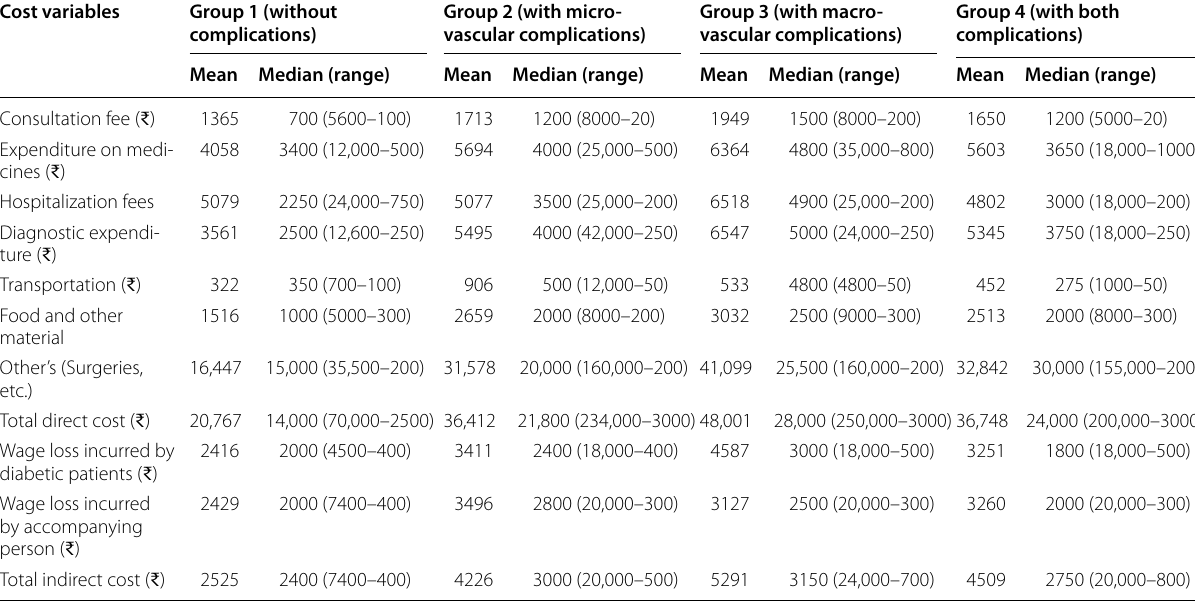
Source: Authors calculation established on primary